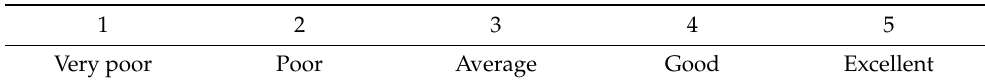
Table 8. Rating scales to fulfil the criteria of